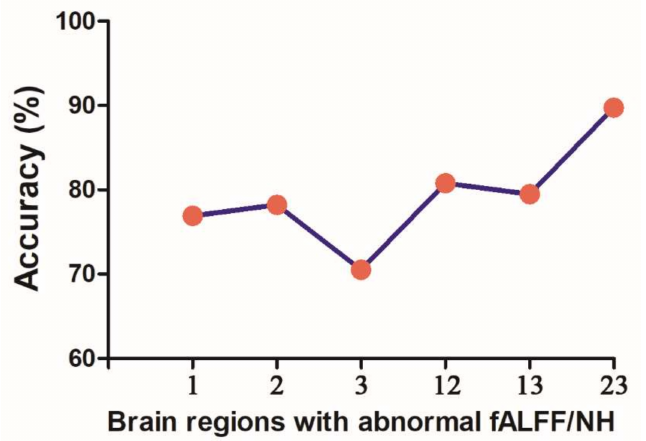
Figure 4. Accuracy (%) of SVM using three brain regions with altered fALFF/NH values of fronto- limbic network to discriminate OCD from HCs. fALFF = fractional amplitude of low-frequency fluctuations, NH = network homogeneity, 1 = right orbitofrontal cortex, 2 = left orbitofrontal cor- tex, 3 = right putamen, SVM = support vector machine, OCD = obsessive–compulsive disorder, HCs = healthy controls.